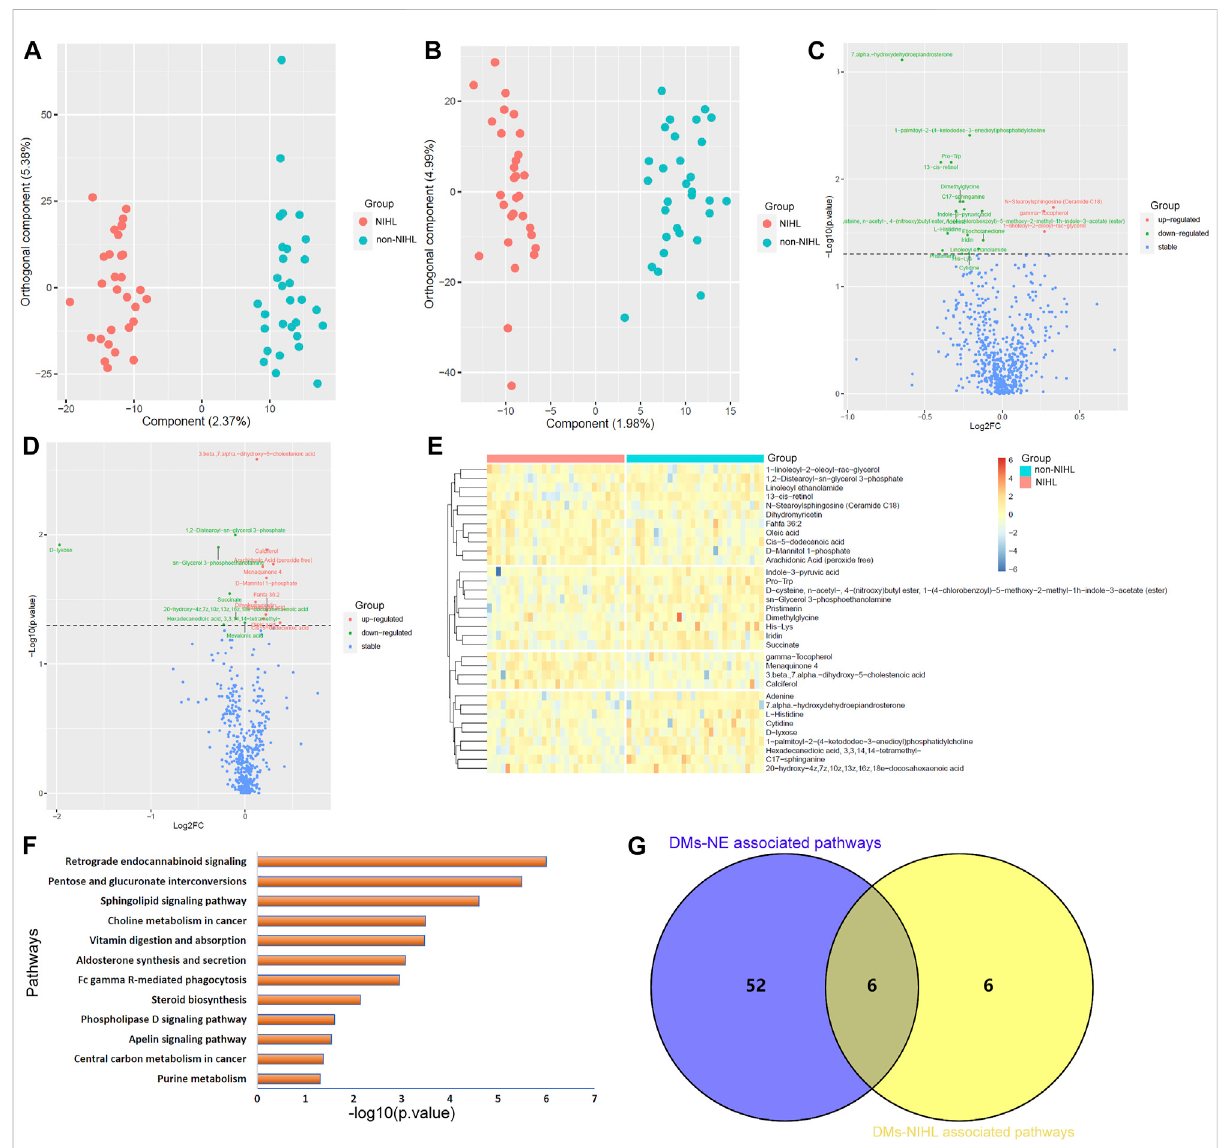
FIGURE 4 OPLS-DA of the plasma metabolites between the NIHL group and non-NIHL group. (A,B) OPLS-DA score plots between the NIHL group and non-NIHLgroupinpositiveandnegativeionmodes,respectively. (C,D) ComparisonsofthemetabolitesbetweentheNIHLgroupandthenon-NIHL group in the positive and negative ion mode, respectively. (E) Expression pro fi les of the metabolites with p < 0.05 and VIP > 1 (DMs-NIHL) inthe NIHL samples and non-NIHL samples. (F) DMs-NIHL were signi fi cantly enriched in 12 KEGG pathways. (G) Six common pathways were associated with both DMs-NE and DMs-NIHL. The Wilcoxon test and OPLS-DA were used for analyses, and they were performed by R 4.0.3 software. The metabolites with p < 0.05 in the Wilcoxon test and VIP > 1 in the OPLS-DA were considered signi fi cant. OPLS-DA, orthogonal partial least squares discrimination analysis; VIP, variable importance in projection; log 2 FC, log 2 (Fold change); NIHL, noise-induced hearing loss; non-NIHL, without NIHL. DMs-NE, differential metabolites associated with noise exposure; DMs-NIHL, differential metabolites associated with